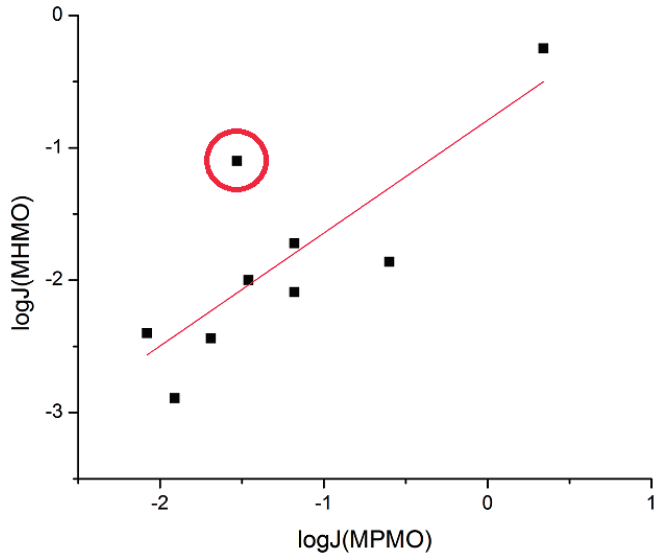
Figure 1. Plot of experimental (Exp.) log J is